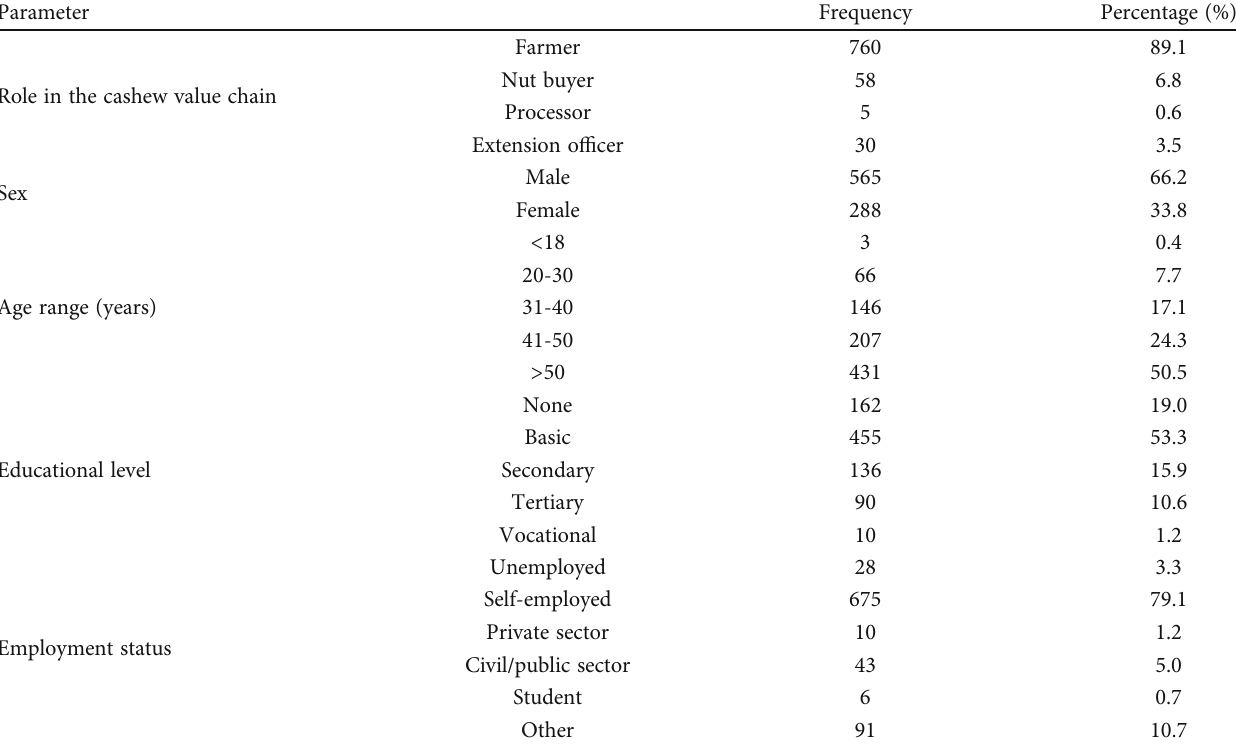
Table 1: Demographic information of stakeholders in cashew value chain in